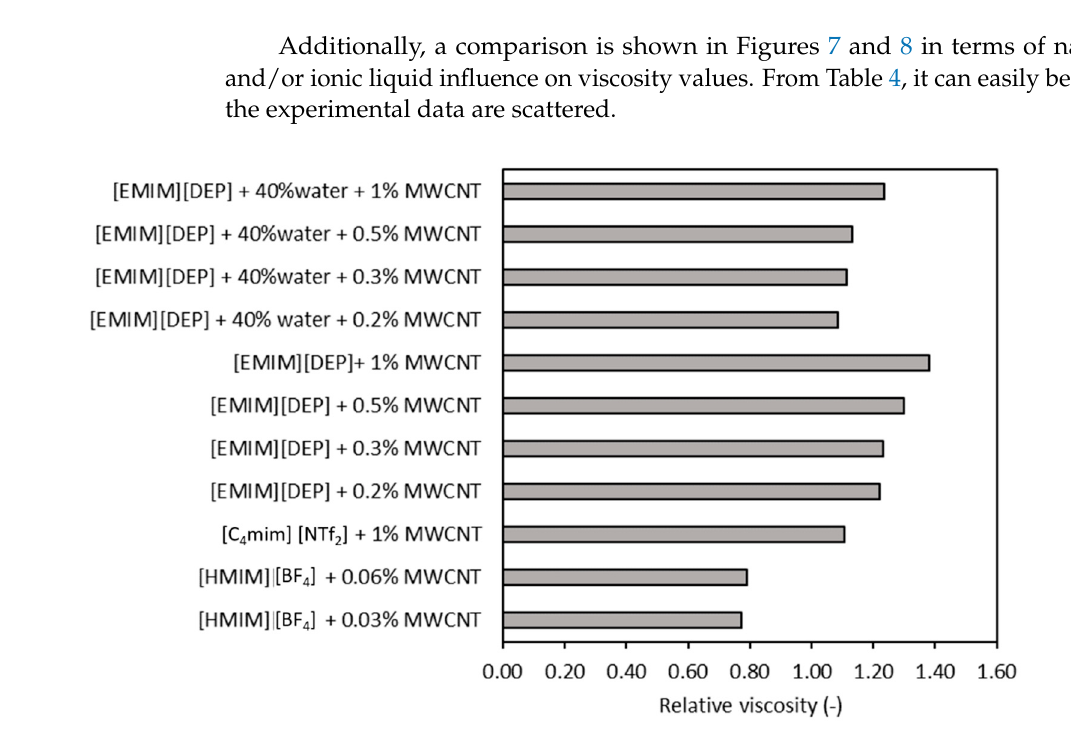
Nanomaterials 2021 , 11 , x FOR PEER REVIEW 14 of 24